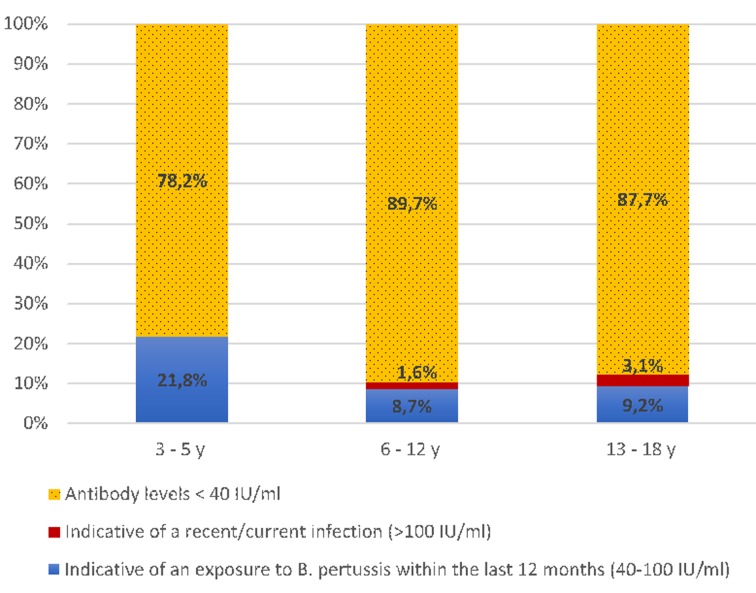
Frequency of anti-PT IgG levels in different age groups.